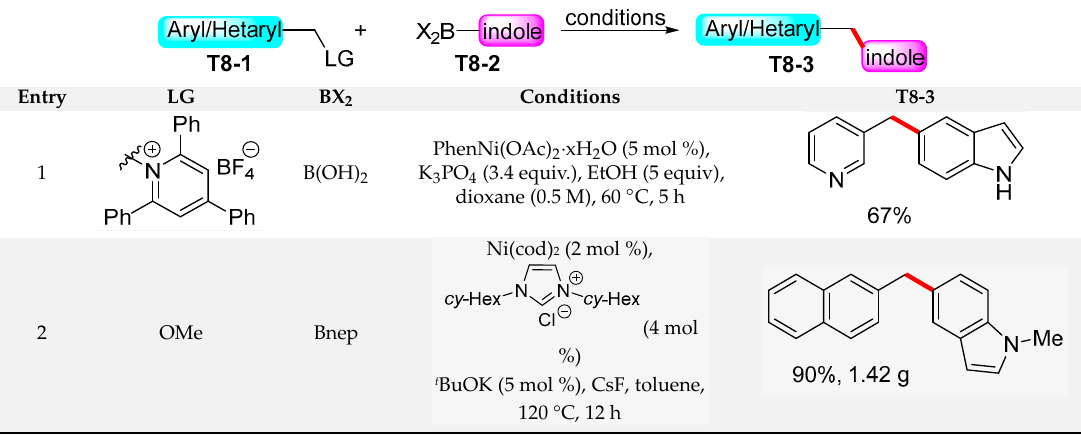
Table 8. The benzylation of indolylboronic acids.